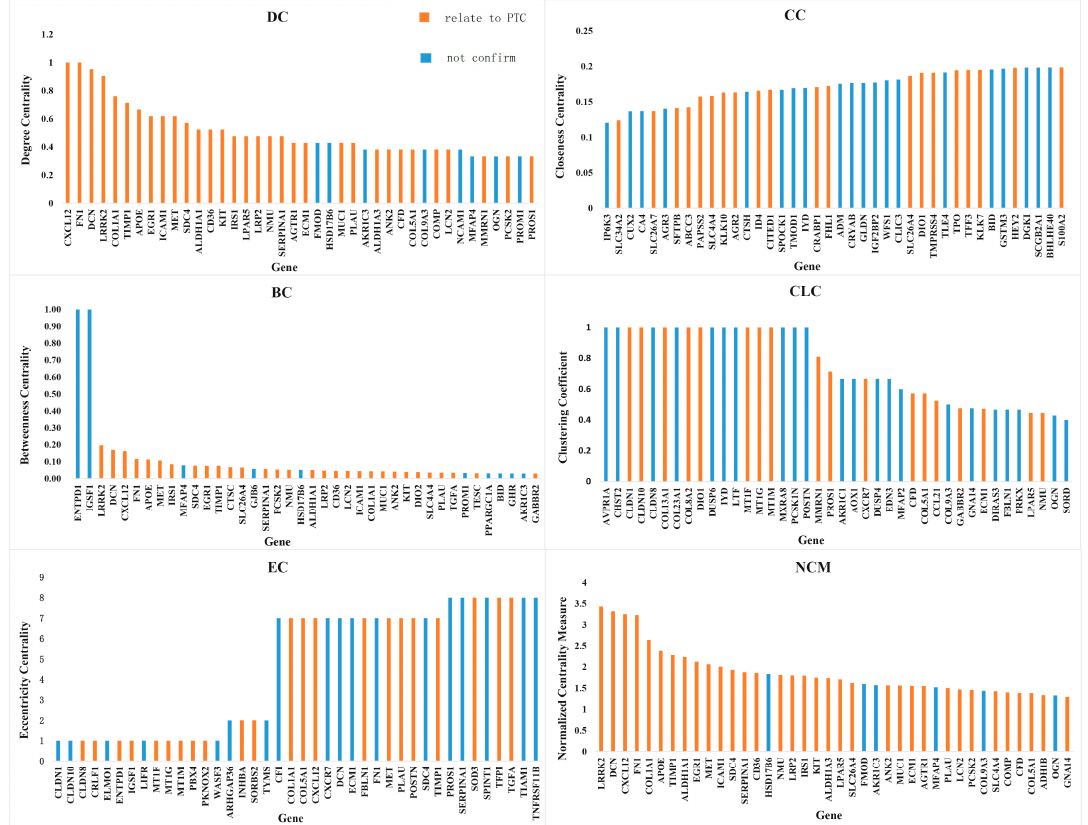
Figure 3. Histograms of topological property values of genes. The genes represented by the histograms of orange have been confirmed to be related to papillary thyroid carcinoma (PTC); the genes represented by the histograms of blue have not been confirmed to be related to PTC.